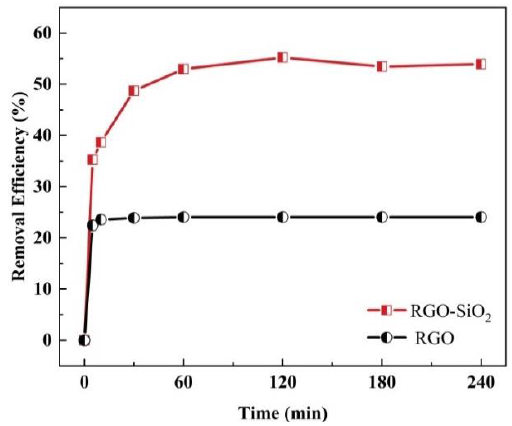
Figure 6. Adsorption of RGO and RGO-SiO 2 on HA.